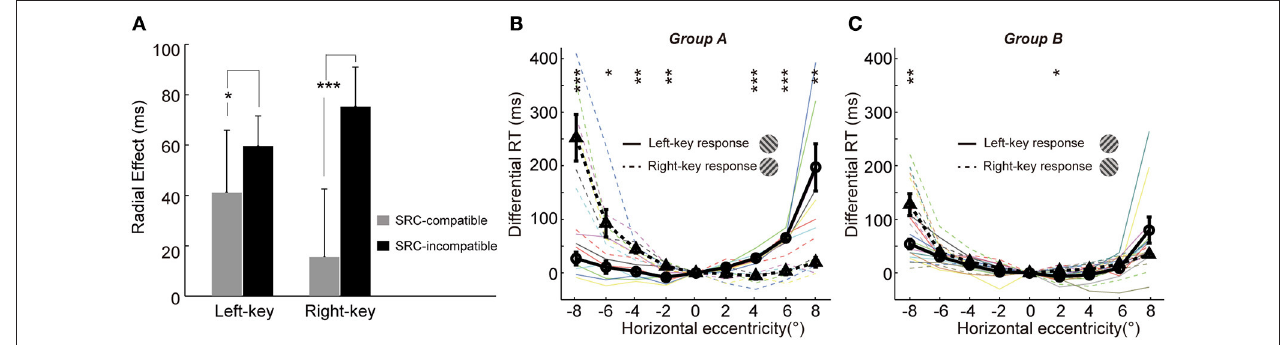
FIGURE 4 | Mutual interaction between the radial effect and SRC effect. (A) The influence of SRC effect on the radial effect. The radial effect is shown in the SRC-compatible (gray) and SRC-incompatible (black) conditions with left-key and right-key response, respectively. The error bars denote SD . (B,C) The influence of the radial effect on SRC effect. The differential RT is plotted against the grating horizontal eccentricity in group A (B) and B (C) . The solid black curve (through circles) and dashed black curve (through triangles) represent mean differential RTs with left-key and right-key responses, respectively. The black vertical bars denote ± SEM. The thin solid and dash color lines represent the differential RTs of individual subject with left-key and right-key responses, respectively. Asterisk denotes the results of post-hoc paired t -tests between left-key and right-key responses in each group: * P < 0.05, ** P < 0.01, *** P < 0.001.